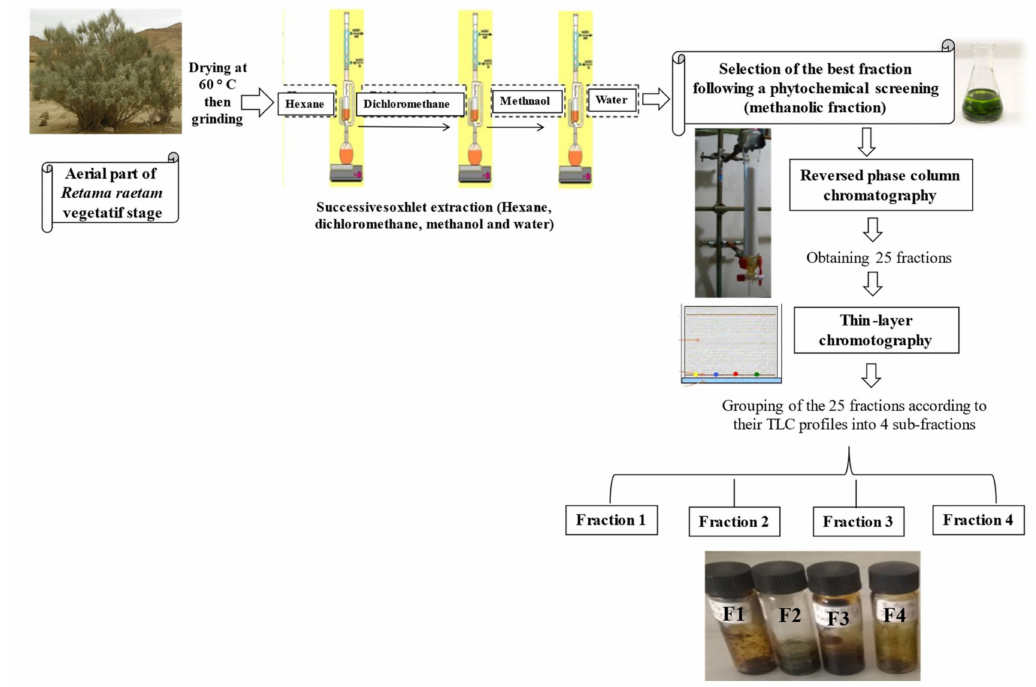
Figure 4. Graphical scheme of the performed processes for the obtaining of R. raetam methanolic extract (MeOH-E) and the subsequent fractions (F1, F2, F3,